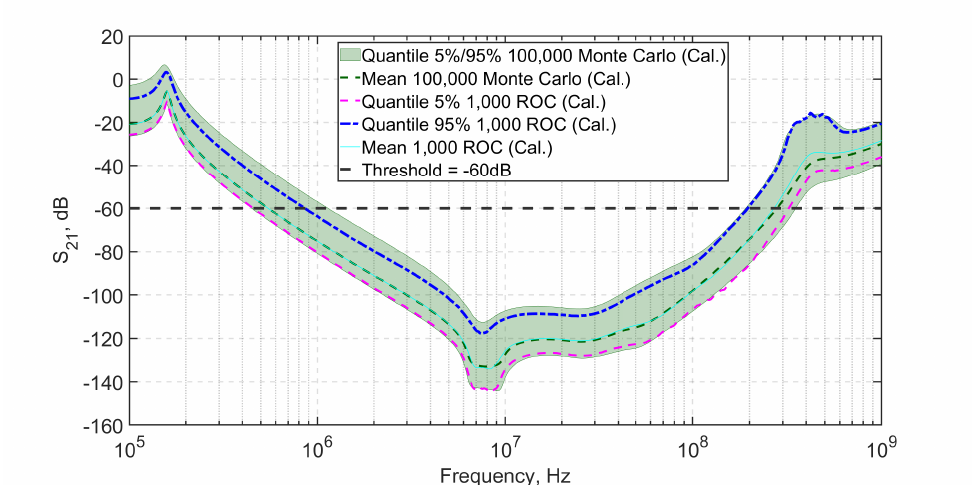
Figure 22. Filtering performances: 5%/95% confidence intervals from Test case #2/Channel #4 including MC samples and ROC calculations.